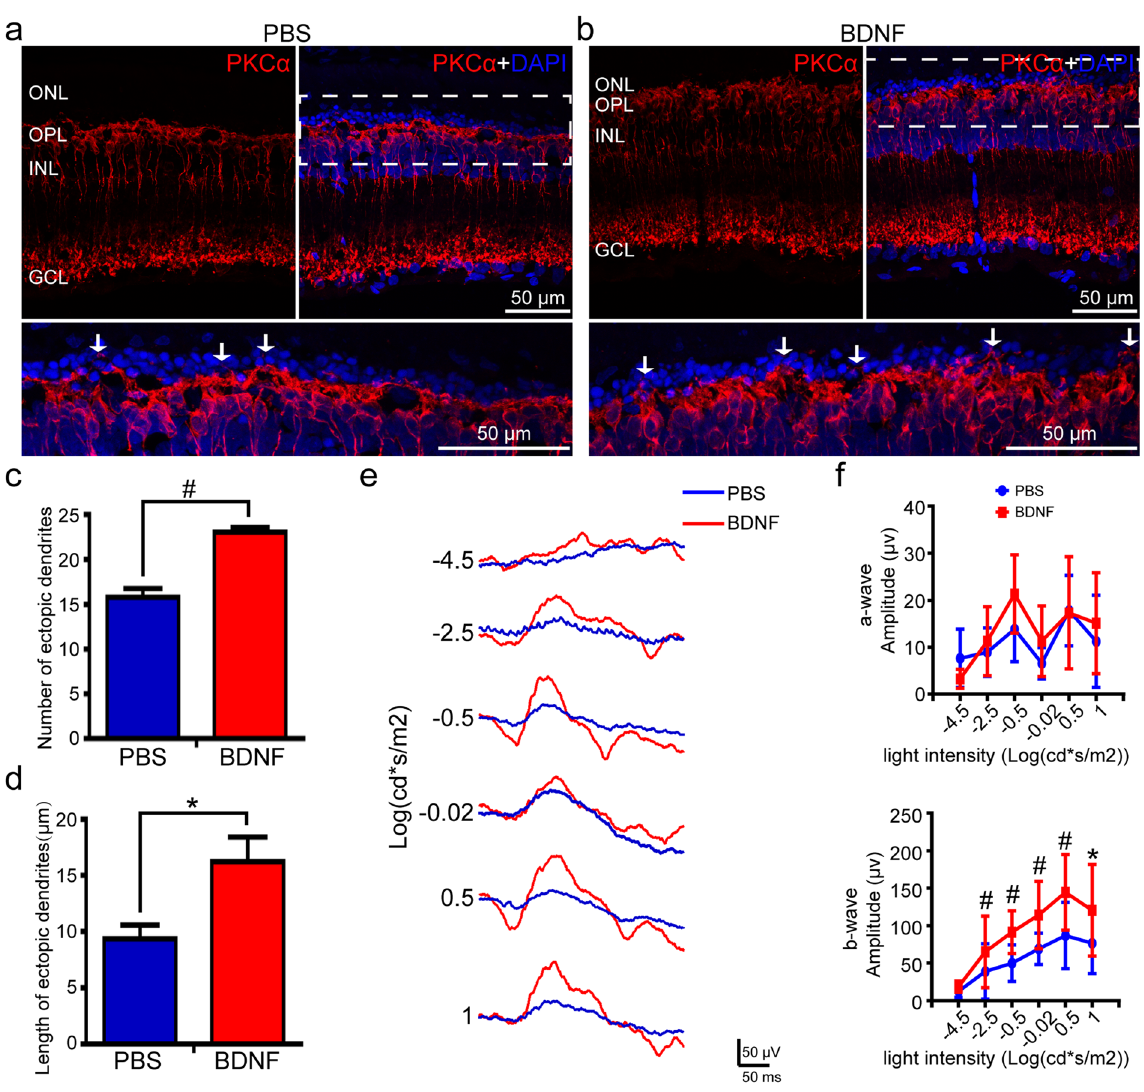
Figure 6. BDNF treatment increased the number and length of RBC ectopic dendrites and the ERG responses in RCS rats. Immunostaining of PKC α in the retinae of P60 RCS rats, five weeks after ( a ) PBS (control) or ( b ) BDNF treatment. Bottom sub-panel shows magnification of the dotted area in the top right subpanel. Arrows indicate ectopic dendrites. ( c ) Number of RBC ectopic dendrites in retinae of RCS rats, five weeks after PBS or BDNF treatment, per field view (213 µ m × 213 µ m) (bars show means; error-bars, SEM; n = 5). ( d ) Same for length of ectopic dendrites (n = 5) ( e ) Representative ERG traces in RCS rats, five weeks after subretinal injection of PBS or BDNF. ( f ) Group data for the amplitude of a-waves (top) and b-waves (bottom) from ERG recordings in RCS rats, five weeks after surgery (bars, means; error-bars, SD; n = 10). ONL: outer nuclear layer; OPL: outer plexiform layer; INL: inner nuclear layer; GCL: ganglion cell layer. * p < 0.05; # p <